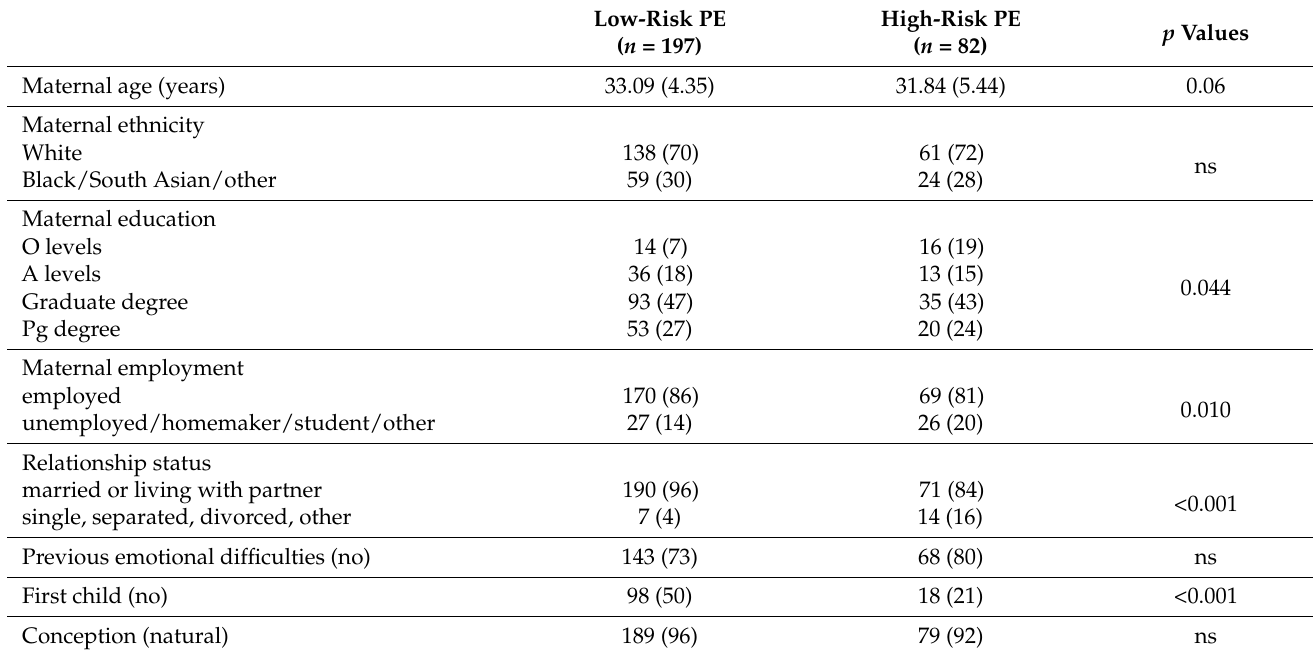
Table 1. Baseline sociodemographic characteristics of the included population (N = 282) by